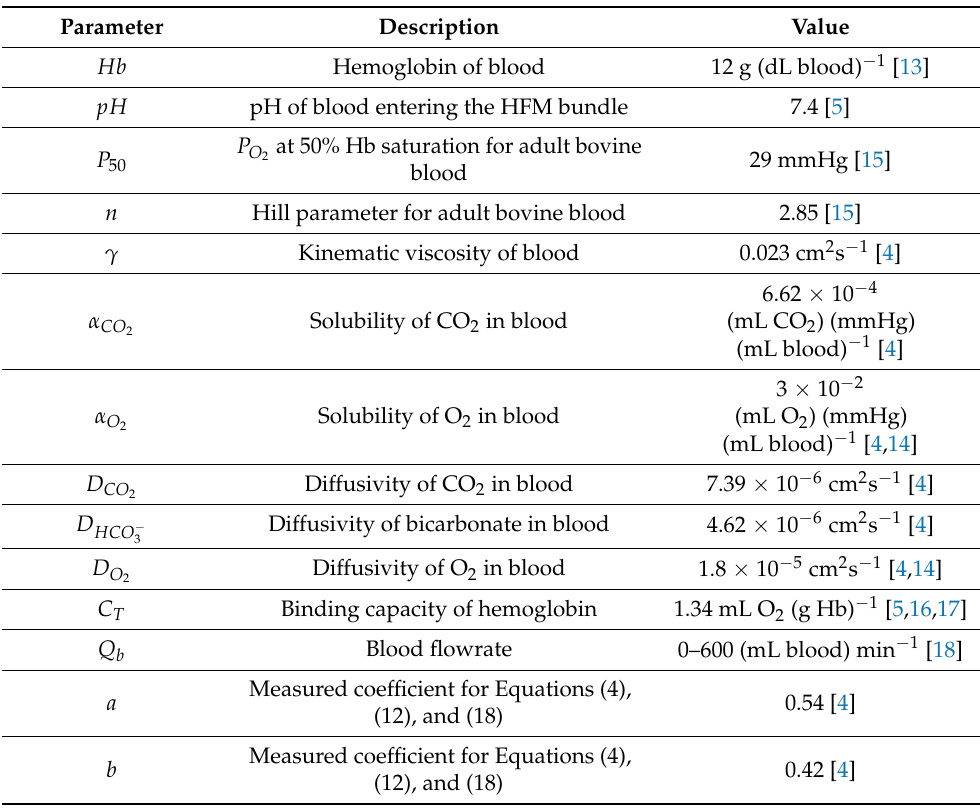
Table 1. Cont . Parameter